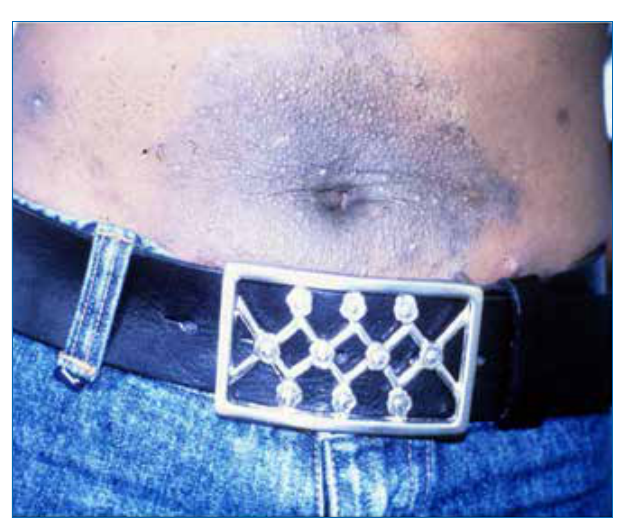
Figure 3: Nickel dermatitis due to buckle of belt